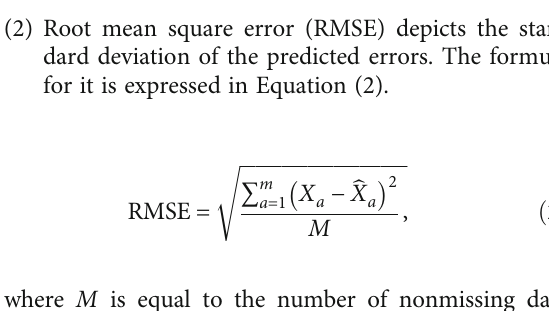
Figure 5: RMSE score obtained by the applied